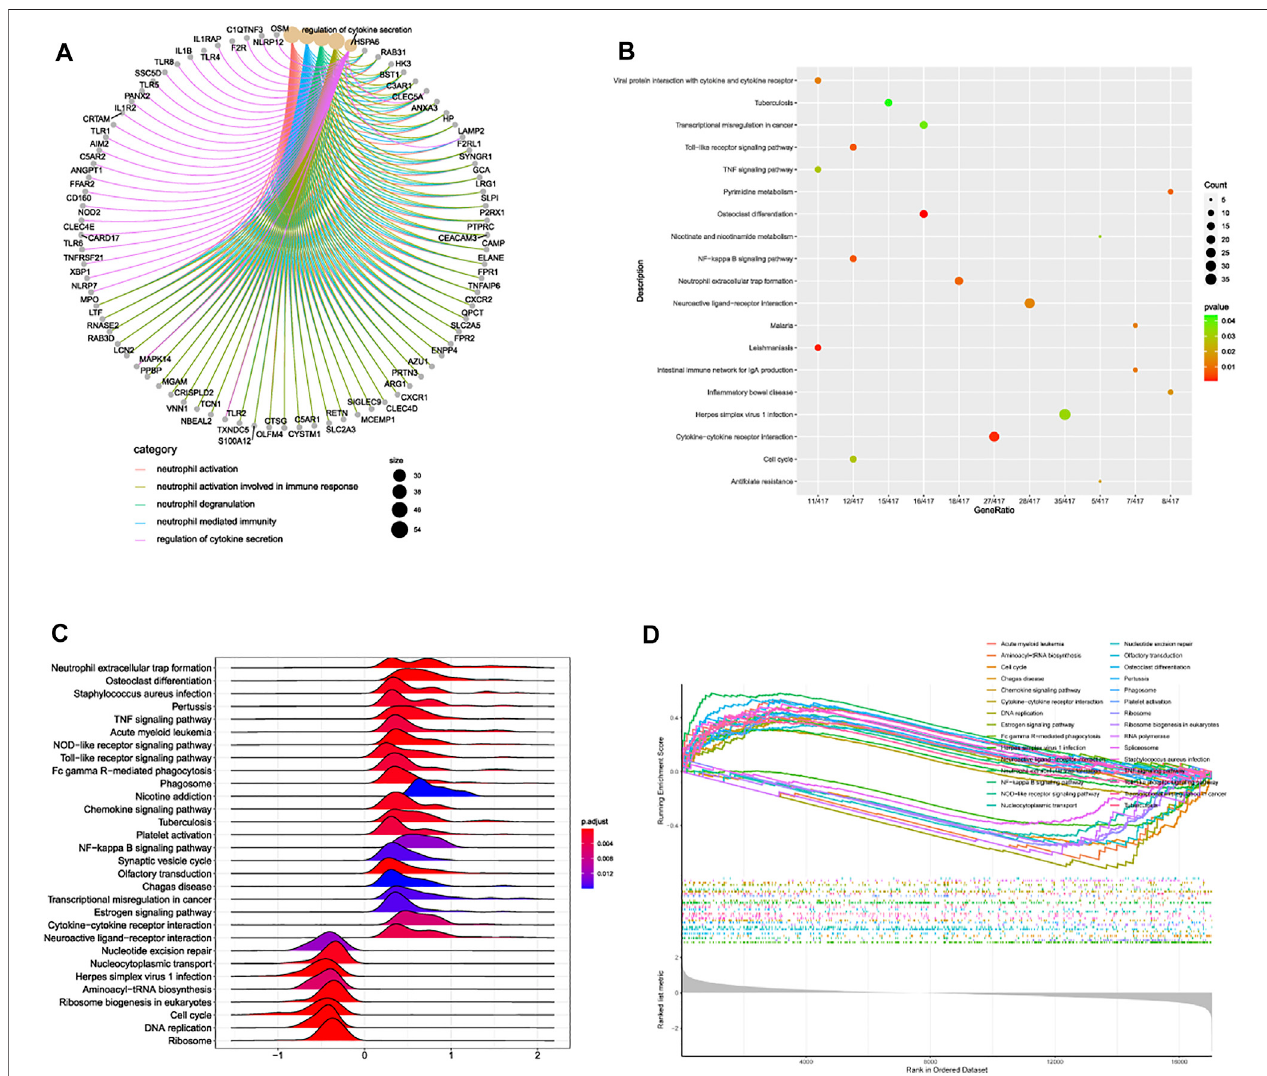
FIGURE 2 | (A) association network diagram depicting the most correlated functions and corresponding genes. (B) bubble plot of pathway enrichment analysis. (C) ridge plot and (D) line graph of GSEA analysis.